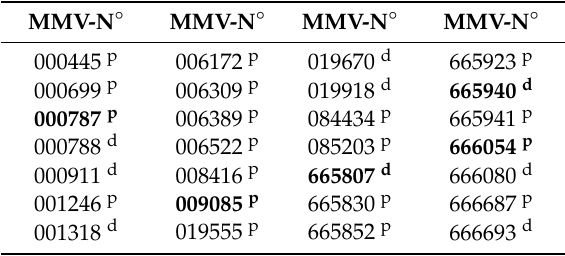
Table A1. Overview of the 28 Malaria box compounds with specific activity against Neospora caninum